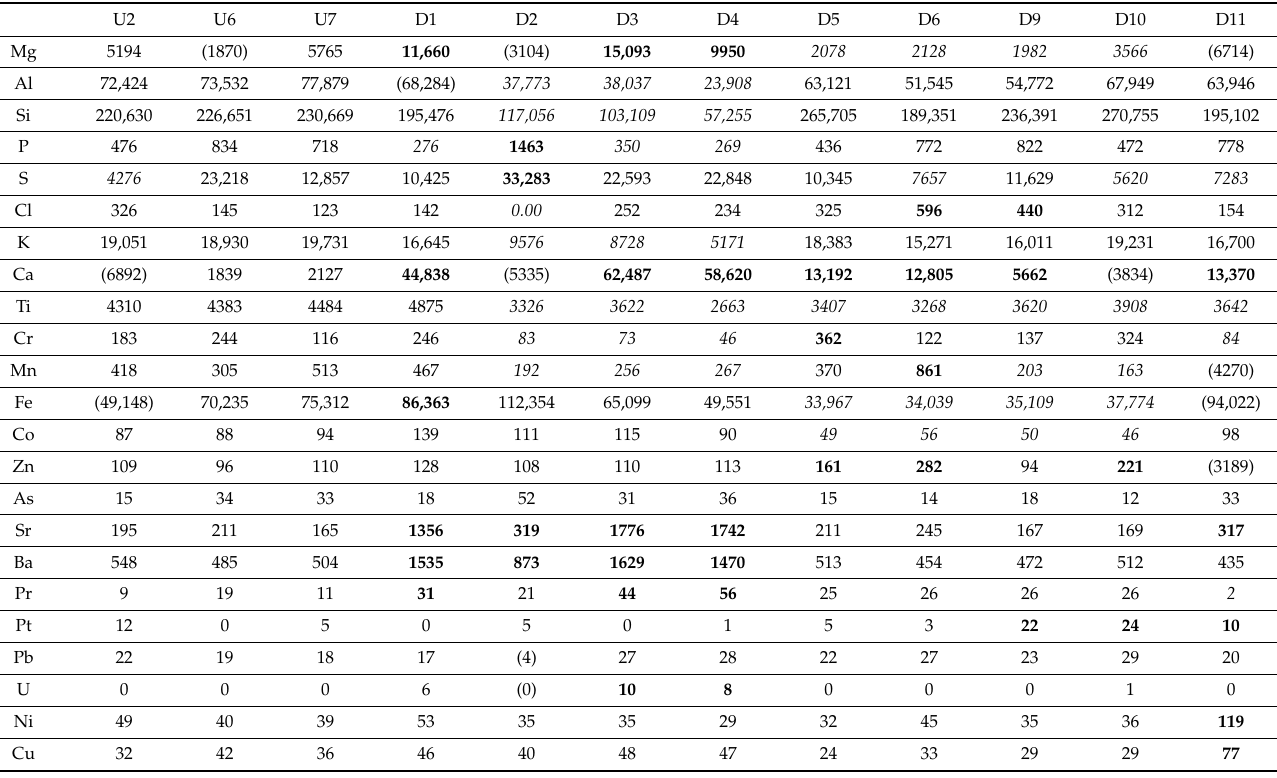
Table 6. XRF values by element in ppm and location (rounded to the nearest whole number). Values highlighted in bold were the downstream values that appeared to be notably higher than the values from the upstream group. Values highlighted in italics were the downstream values that appeared to be notably lower than the values from the upstream group. Values in parentheses indicate results that did not appear to fit the trend and were treated as spikes.